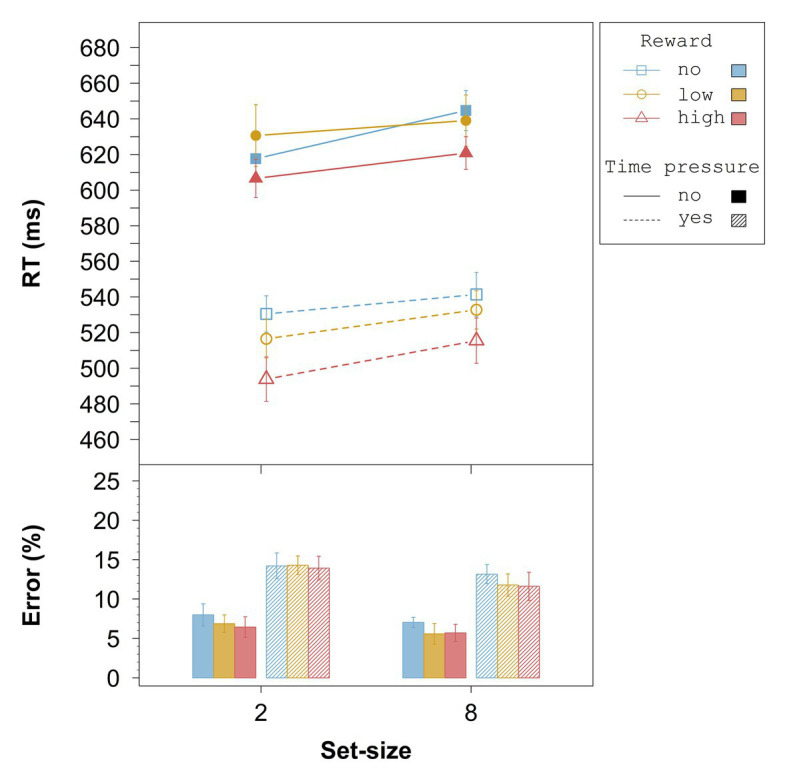
Averaged overall data from Experiment 2. Error bars represent 95% within-subject confidence intervals (Loftus and Masson, 1994; Morey, 2008). RT = response time.